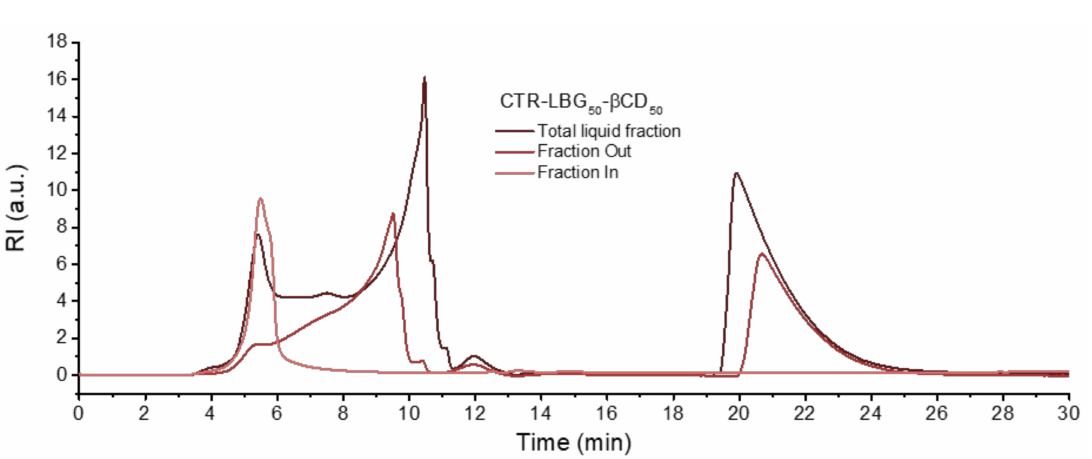
Figure 6. SEC results of soluble fraction obtained from LBG / CD (1:1 ratio) reaction product: total liquid fraction before dialysis, dialyzed liquid (“fraction out”) and high molecular weight fraction retained inside the 3.5 kDa dialysis membranes (“fraction